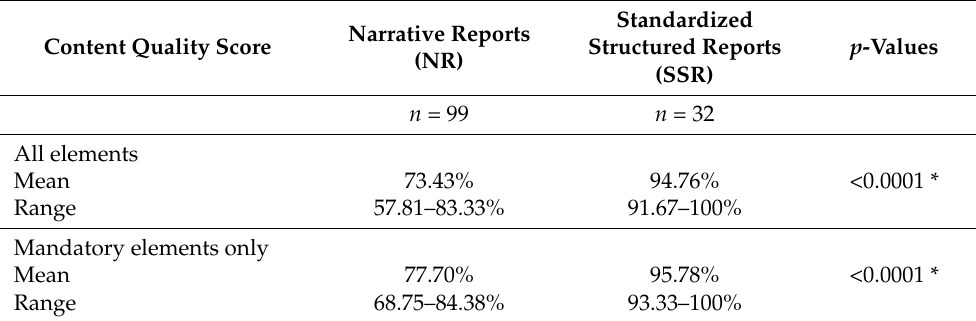
Table 2. Overview of mean total quality scores achieved in NR and SSR. Mean percentages were compared by performing a Mann–Whitney U test. Reports scoring 100% contained all relevant information recommended by ICCR in an explicit and easy to find way. p -values < 0.05 were considered statistically significant and are marked with an